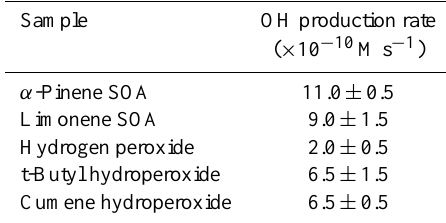
Table 2. OH radical production rates from photolysis of 250µM solutions of SOA and 12.5µM solutions of commercial peroxides, as calculated from the data in Fig. 3 using literature values for the yield of PHBA from the OH oxidation of benzoic acid (see text for